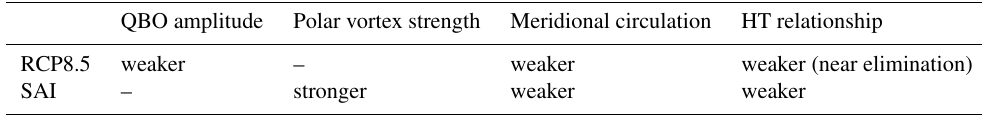
– stronger weaker weaker